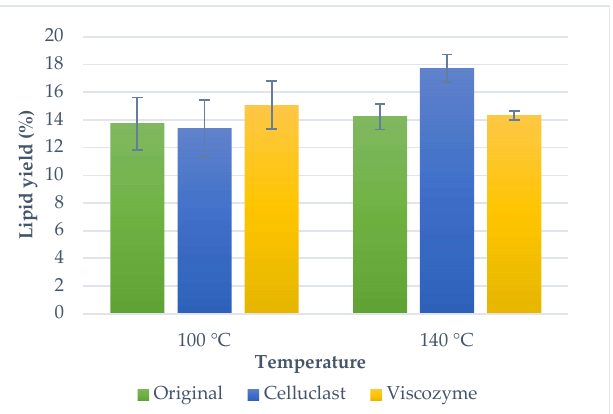
Figure 2. Microalga lipid yield obtained by pressurized liquids extraction (PLE) using different temperatures (100 °C and 140 °C) with and without enzymatic pre-treatments. Error bars denote the standard deviation of two independent determinations.